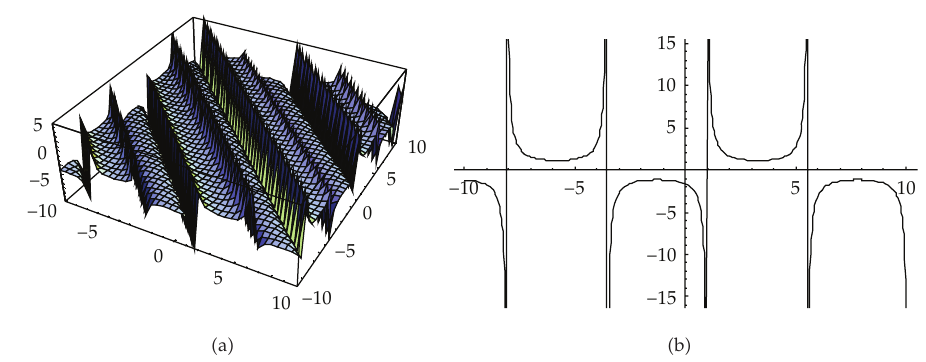
Figure 1: (cid:3) a (cid:4) The graph of (cid:3) 3.8 (cid:4) with a (cid:8) r (cid:8) σ (cid:8) 1 ,b (cid:8) 2 ,m (cid:8) 0 . 5 at t (cid:8) 1, and (cid:3) b (cid:4) is its plane when y (cid:8) 0.